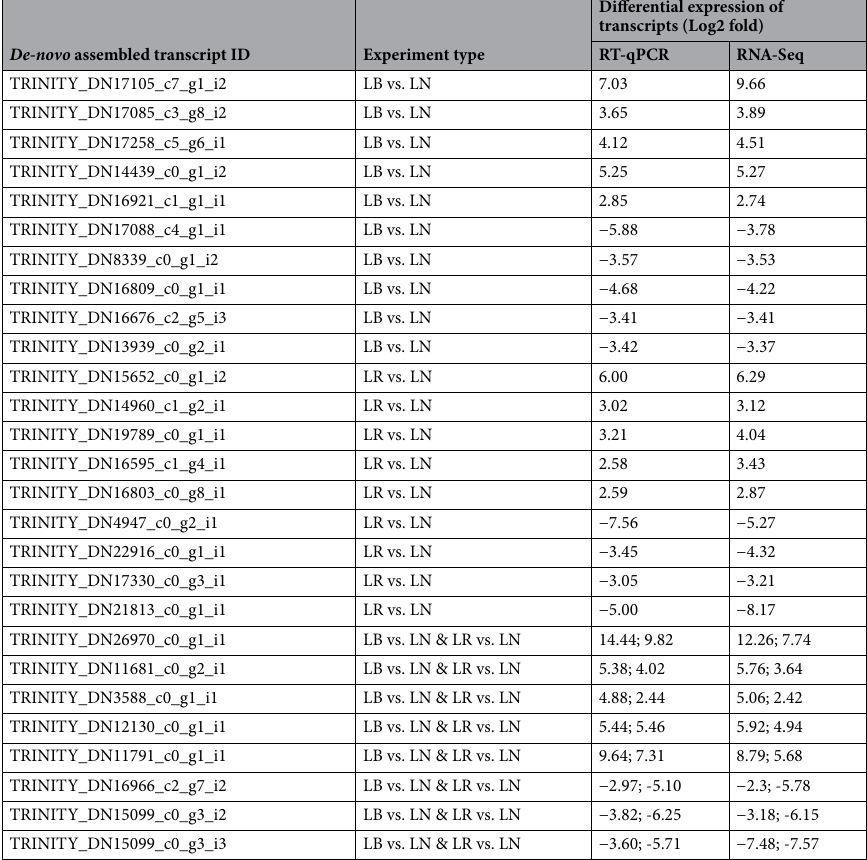
Table 7. RT-qPCR validation of de-novo assembled differentially expressed transcripts. LB: Blue light; LR: Red light; LN: white